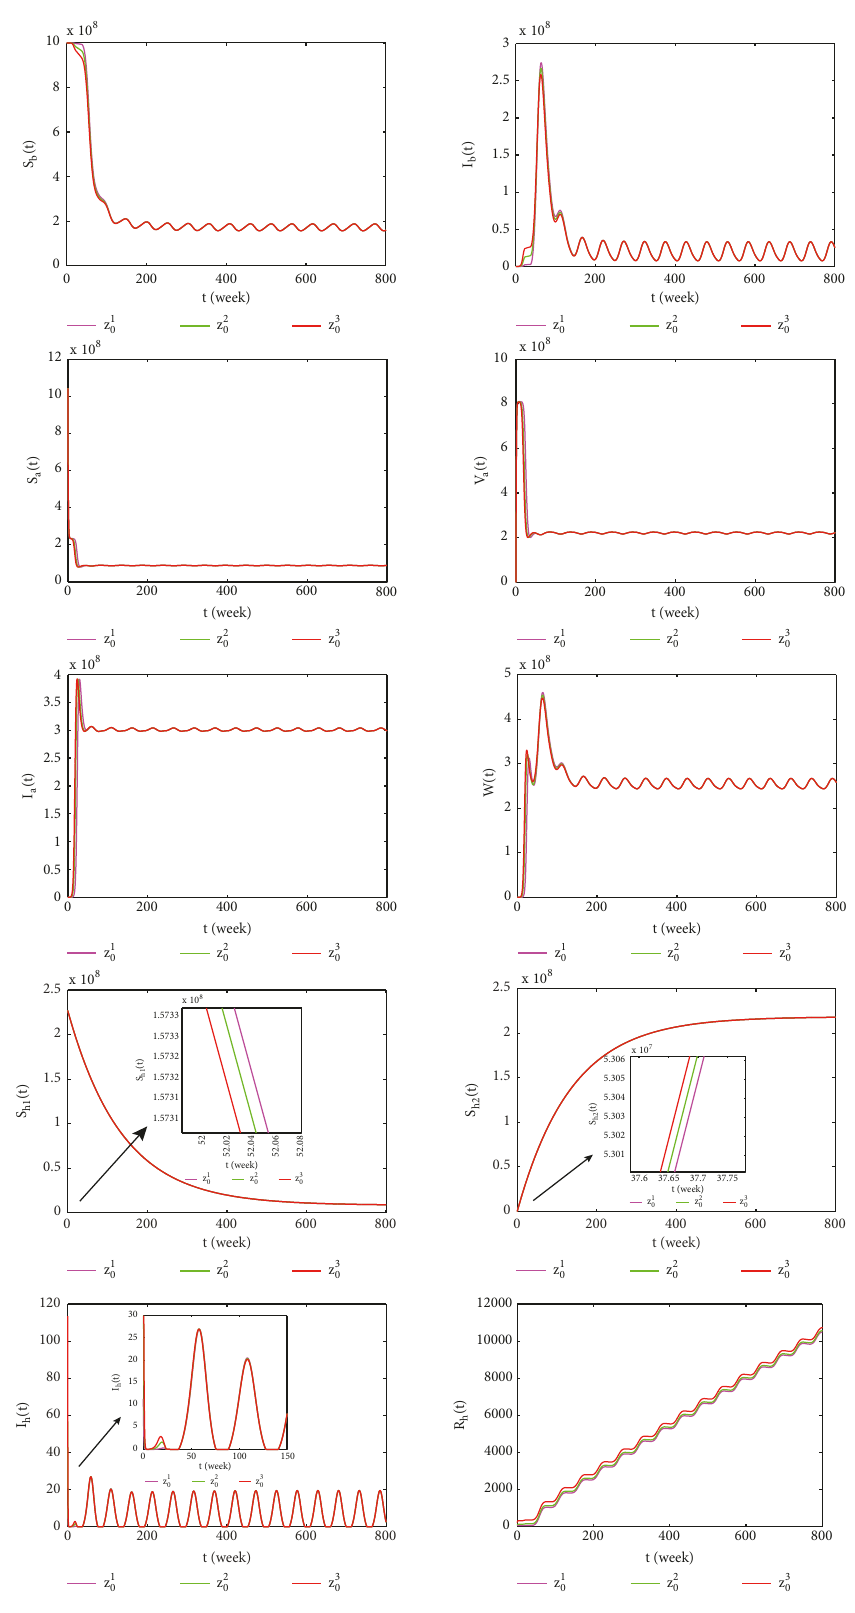
Figure 3: If 𝑅 0 = 2.92 > 1 , the time-variation diagram of system (1) state